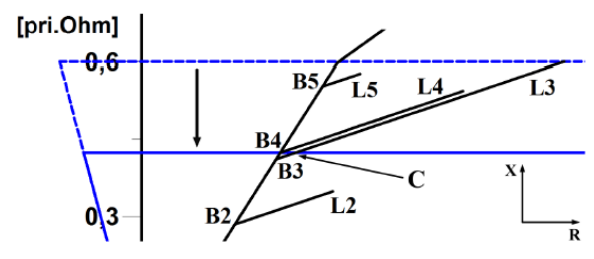
Figure 2. Characteristics of distance protection.